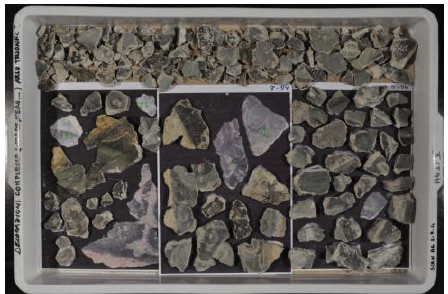
Figure 13. Example of classified fragments.